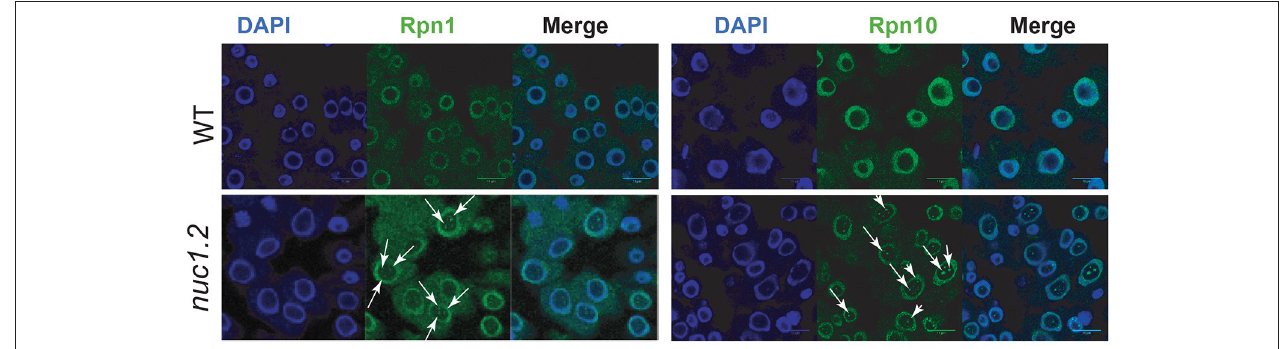
FIGURE 2 | Localization of 26S proteasome subunits in WT and nuc1.2 plants. Immuno-localization of Rpn1a (Left) and Rpn10 (Right) proteasome protein subunits in WT and nuc1.2 root tip cells. Arrows point foci of Rpn1a and Rpn10 proteins in nucleoli of nuc1.2 mutant cells. DAPI staining was used to visualize nucleoplasm and distinguish the